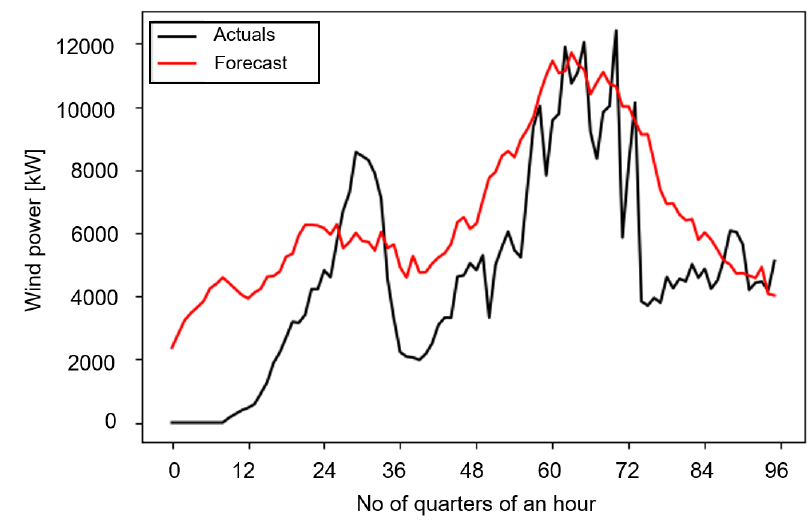
Figure 5. Time series of wind power forecast and actuals for a day of the test